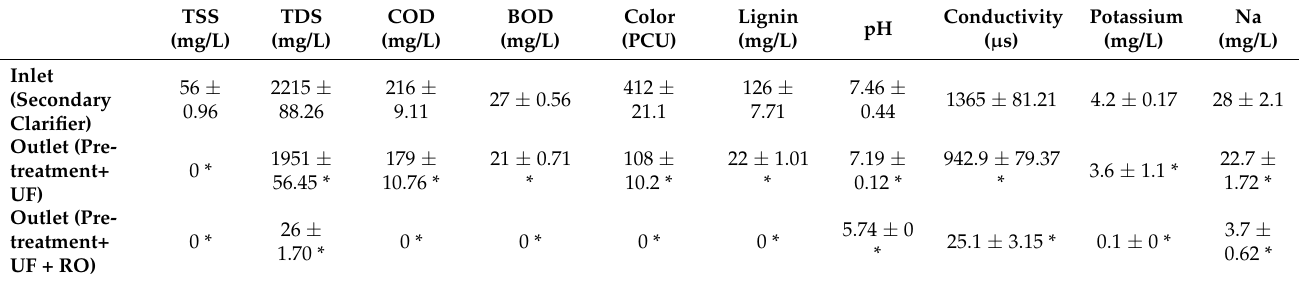
Table 3. Change in the various water parameters with different treatment membrane setups.